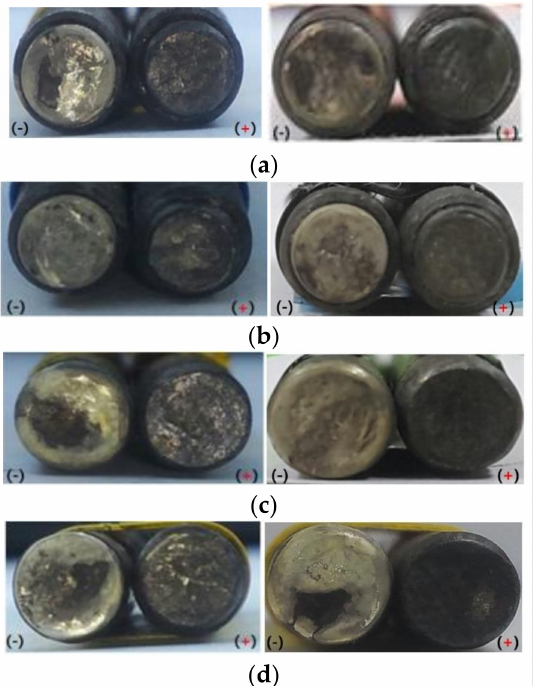
Figure 8. Comparison of deterioration of each electrode material in repeated operations, 10,000 (left photo) and 13,000 (right photo), under the 10 A load current condition, ( a ) AgNi-Cu, ( b ) AgSnO2-Cu, ( c ) AgPd, and ( d )